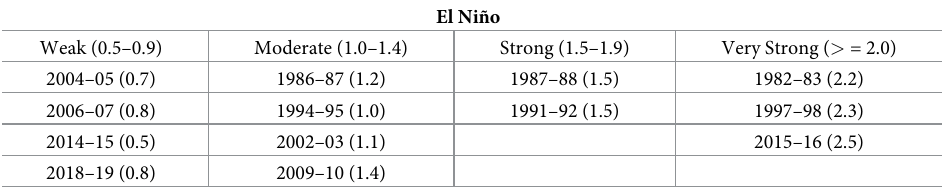
Table 1. El Ni ñ o of different intensities from 1980 to